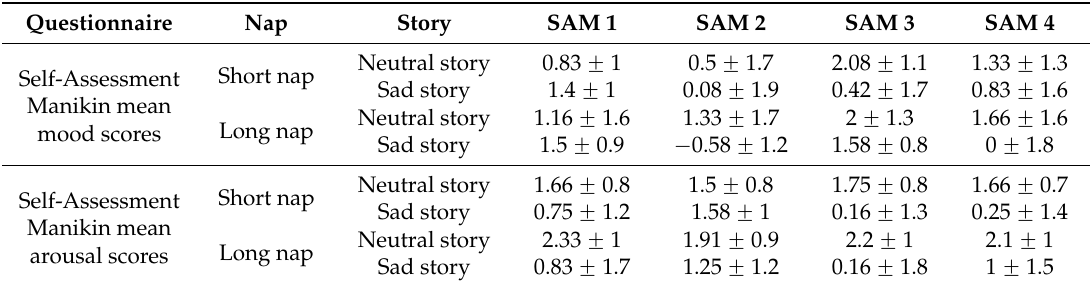
Table 4. SAM mood and arousal scores and skin conductance levels before and after the first audition of the story (before naps) in the sad and neutral story conditions. SAM = Self-Assessment Manikin.